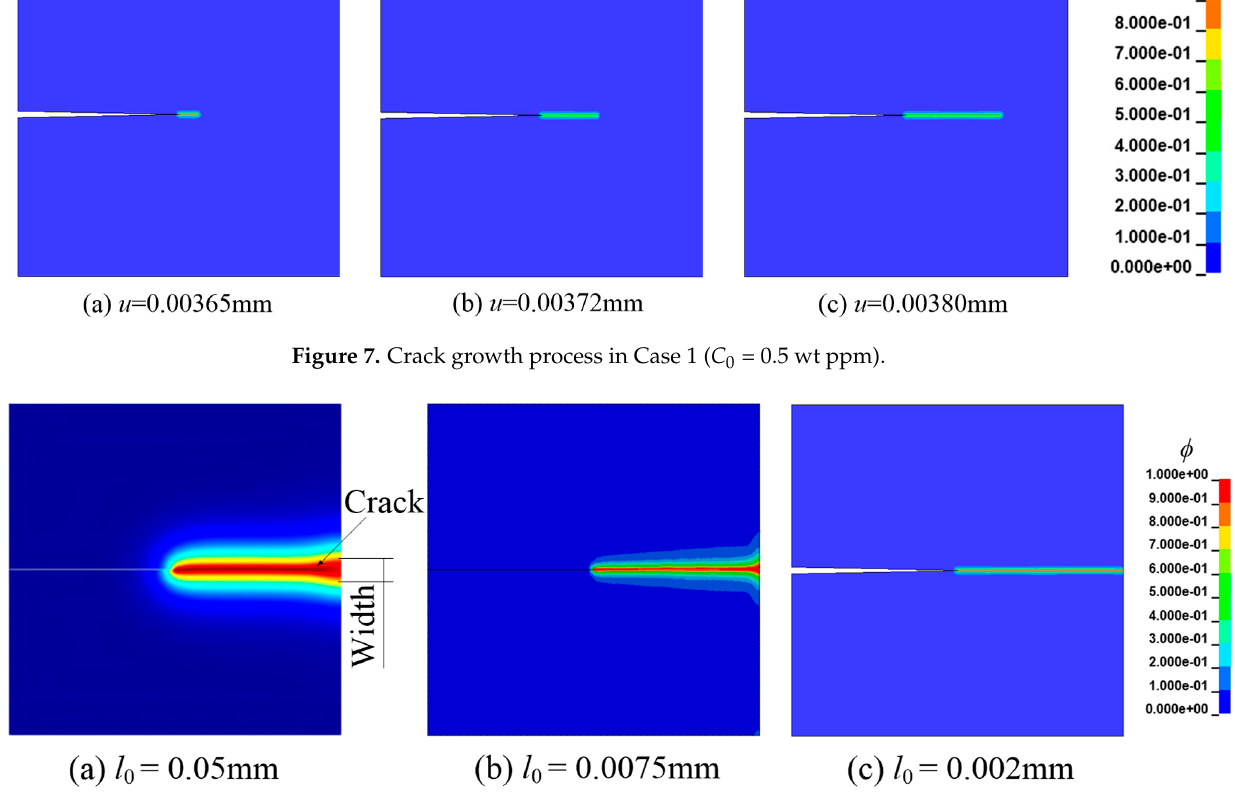
Figure 8. The relationship between crack width and l 0 [3,23].